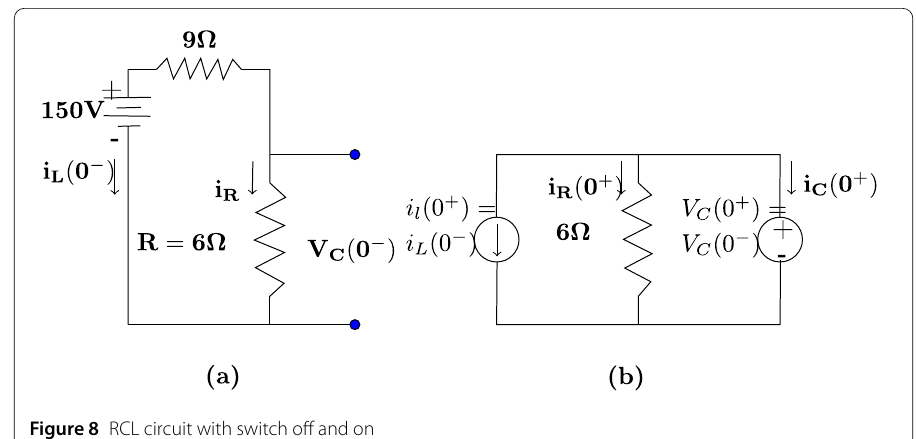
Figure 8 RCL circuit with switch off and